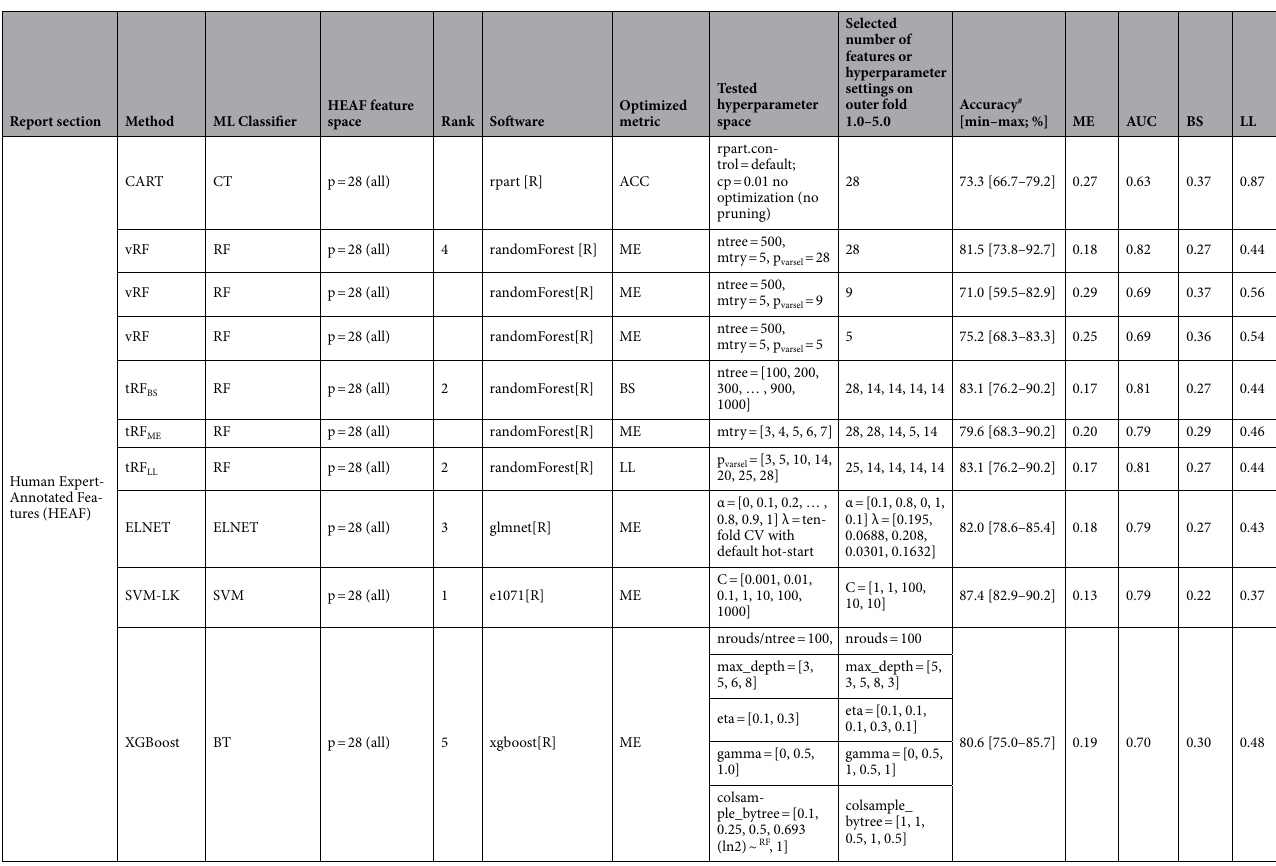
Table 1. Summary table of performance measures of the investigated ML algorithms developed on human expert-annotated features (HEAF). Accuracy#: the averaged fivefold CV accuracy is calculated, ACC: accuracy, AUC: multiclass area under the ROC after Hand and Till (that can only be calculated if probabilities are scaled to 1), BS: Brier score, ME: misclassification error, LL: multiclass log loss, vRF and tRF: vanilla- and tuned random forests, ELNET: elastic net penalized multinomial logistic regression, SVM: support vector machines, LK: linear kernel SVM; XGBoost: extreme gradient boosting using trees as base learners, BT: boosted trees, CART: classification and regression trees; CT: classification tree; cp: complexity parameter used for CART node splitting (for this no optimization (pruning) was performed); ln(2) ~ RF : column sampling (i.e. bootstrap) representing the settings equivalent to running RF in the xgboost library, [R]: R statistical software